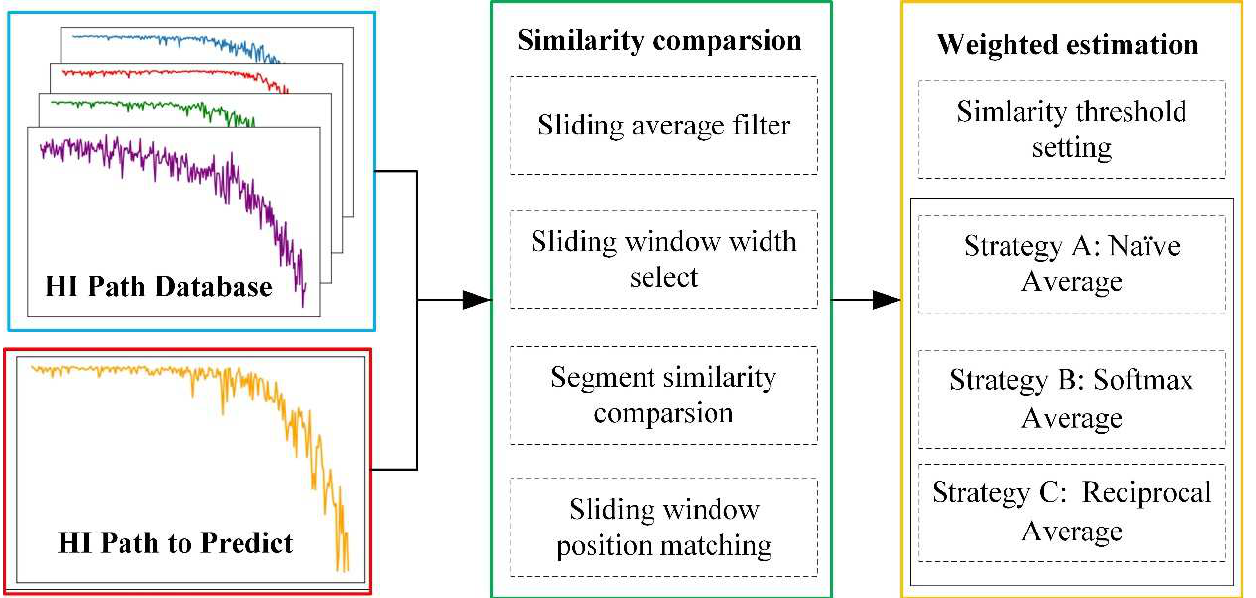
Figure 6. RUL prediction based on similarity comparison.